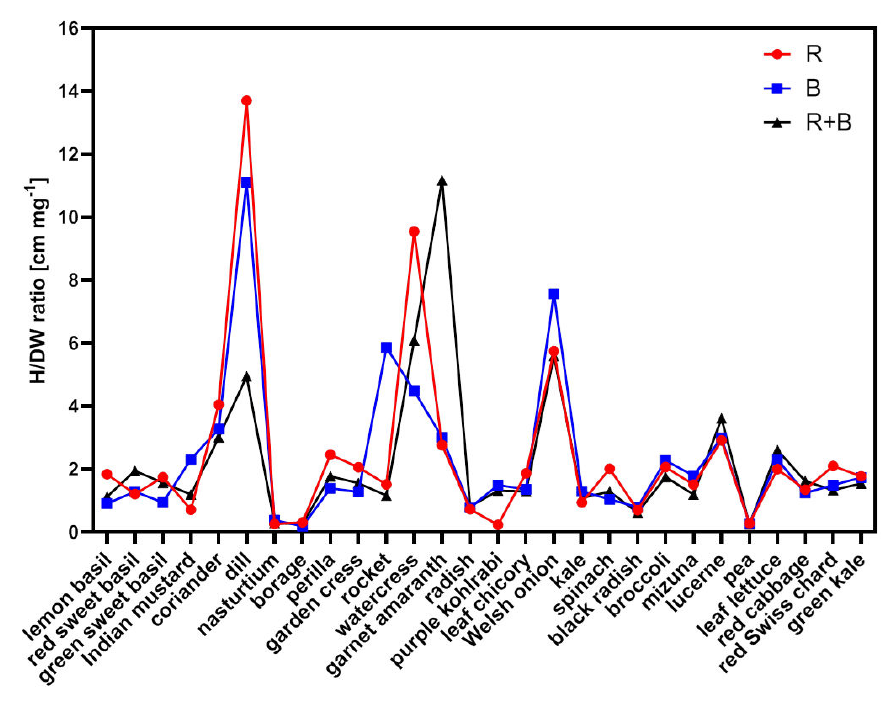
Figure 4. The H/DW ratio of 28 microgreen crops depending on light combinations. The Red: Blue ratio for each combination–R light 6.7; B light 0.6; R + B light